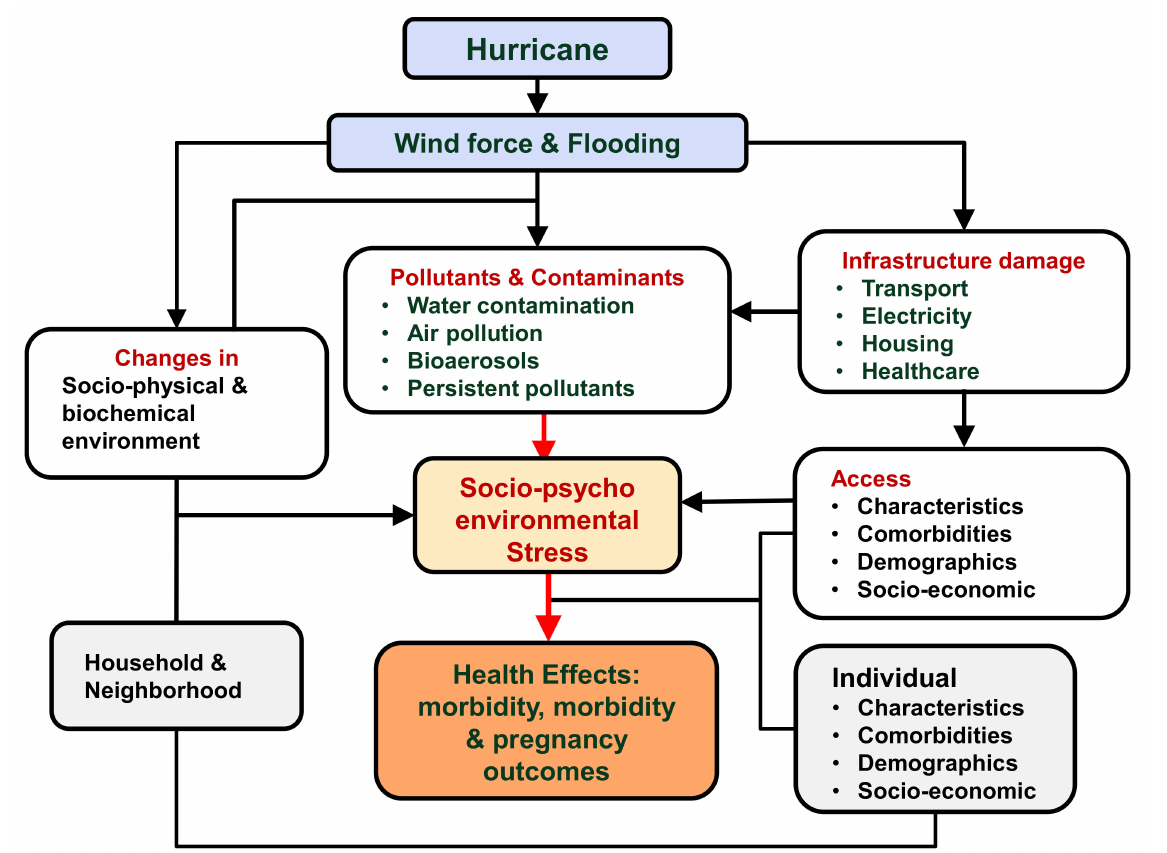
Figure 1. A conceptual model of the direct and indirect health effects of